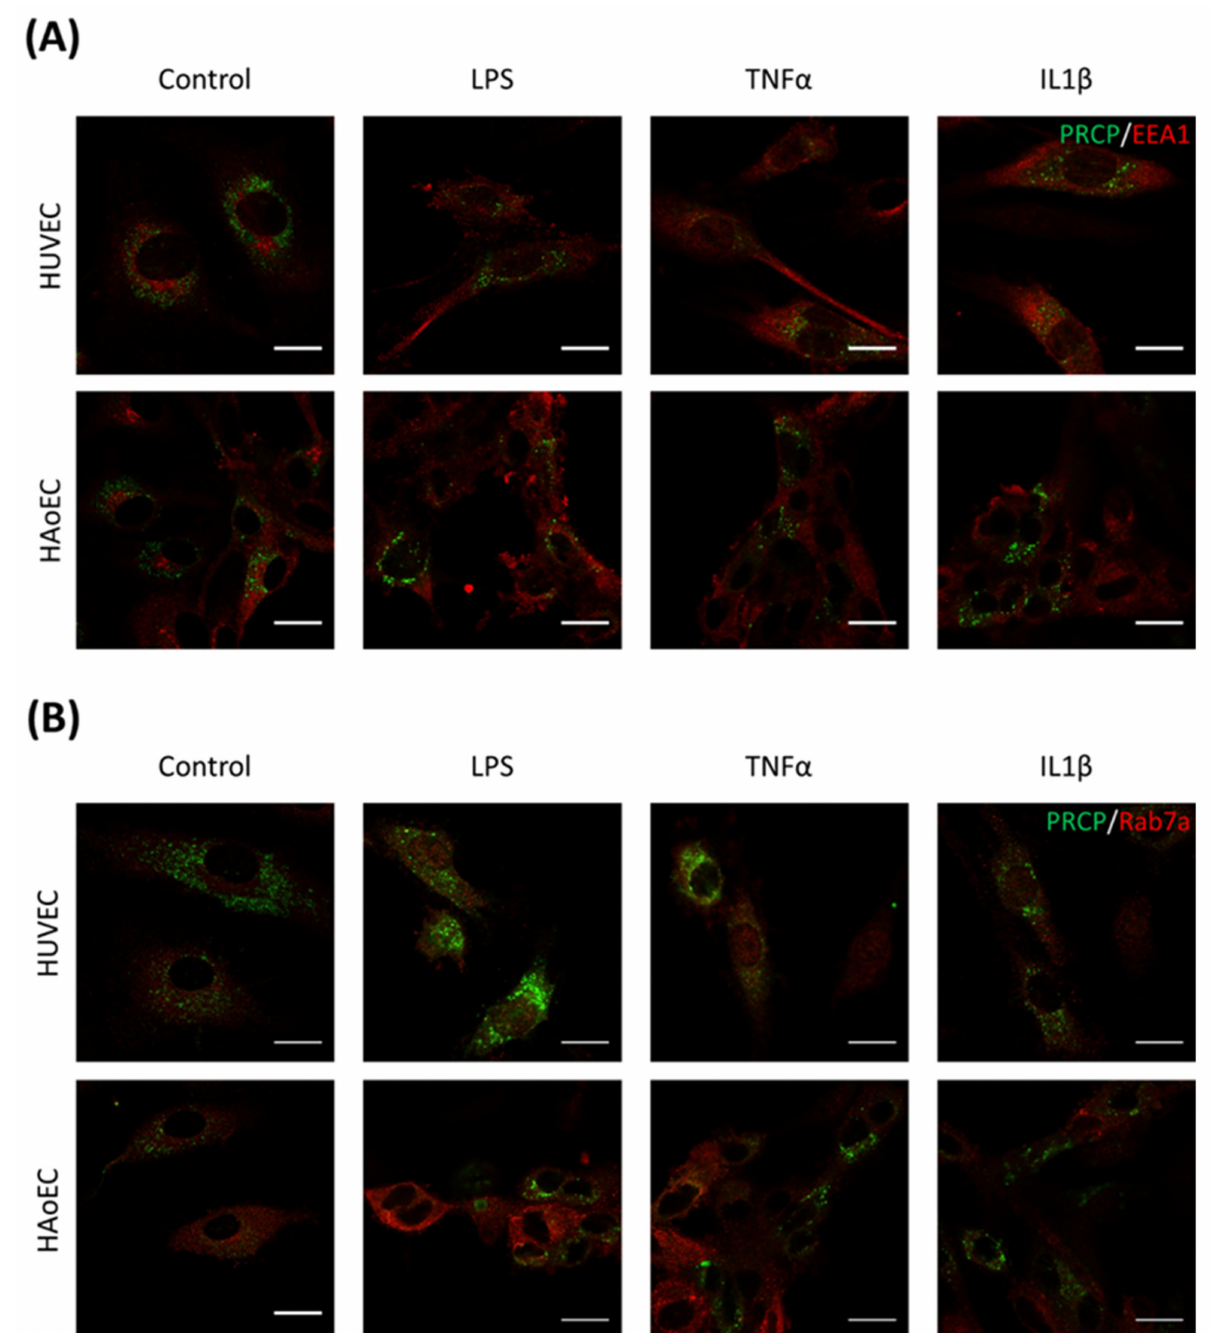
Figure 8. PRCP is not observed in the early or late endosomes of HUVEC or HAoEC. Double staining of PRCP and EEA1/Rab7a in control, LPS-, TNF α -, and IL-1 β -stimulated HUVEC ( A ) and HAoEC ( B ). Cells were incubated for 16 h with the different stimuli, fixed with 4% PFA, permeabilized with 0.1% Triton X-100 and stained for PRCP (green) and EEA1/Rab7a (red). Representative images of three independent experiments. (bar = 20 µ